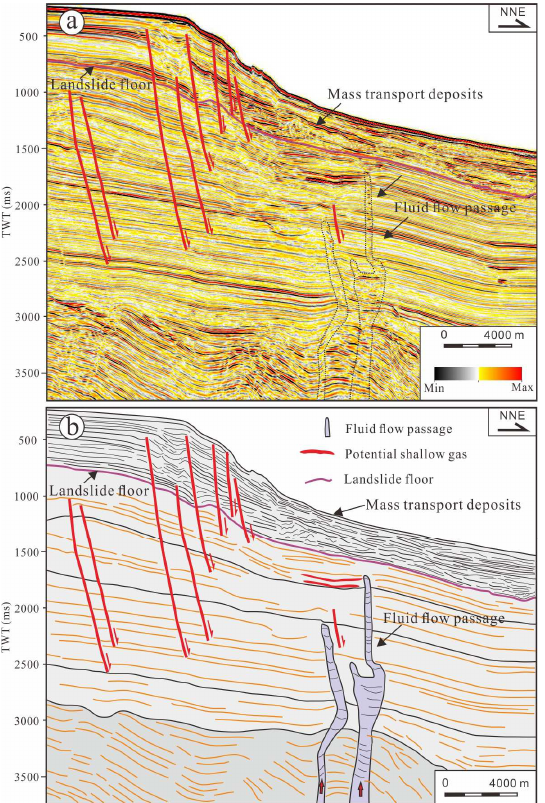
Figure 5. Seismic profile ( a ) and geological interpretation ( b ) showing the mass transport deposits with fluid flow activity at a steep slope break zone of the southern South China Sea. A large number of stepped faults developed in this area. Potential shallow gas accumulates with strong amplitude anomalous reflections at the top of the fluid flow passage. The location of Figure 5 correspond to the red line D in Figure